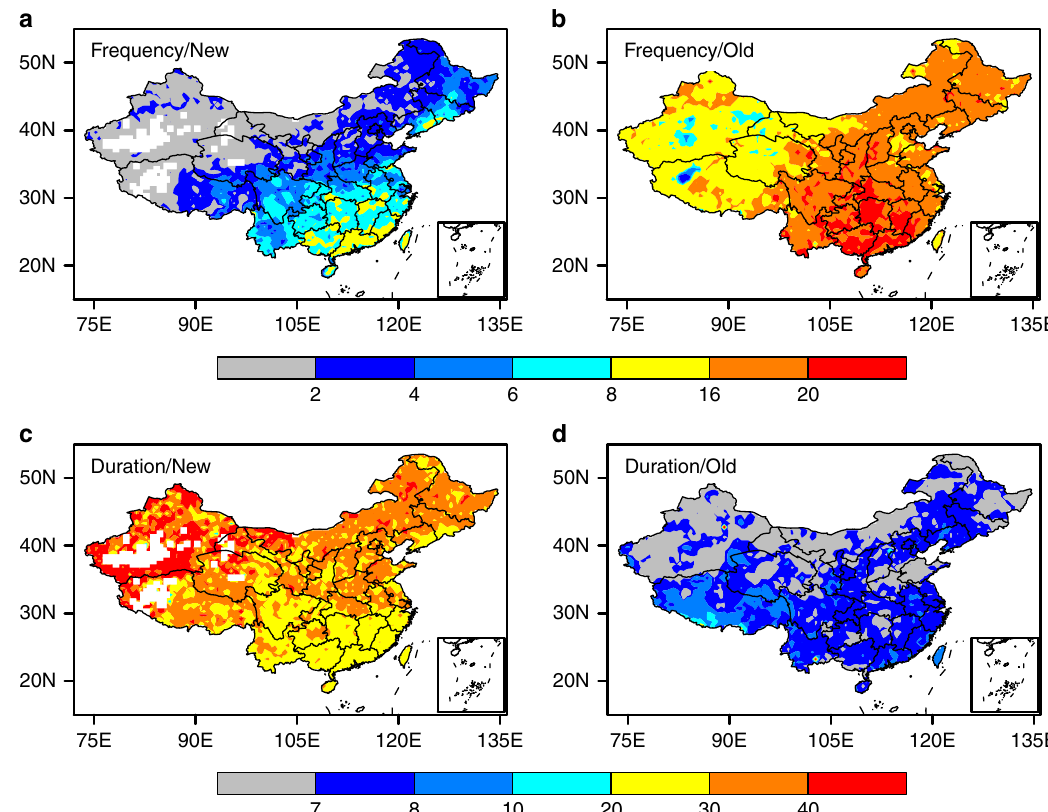
Fig. 2 Comparison of mean frequency and duration of fl ash drought events based on two de fi nitions. Mean results for the number of fl ash drought events per decade a , b , and durations (days) of fl ash drought events c , d . All statistics are based on the average results from three land surface model